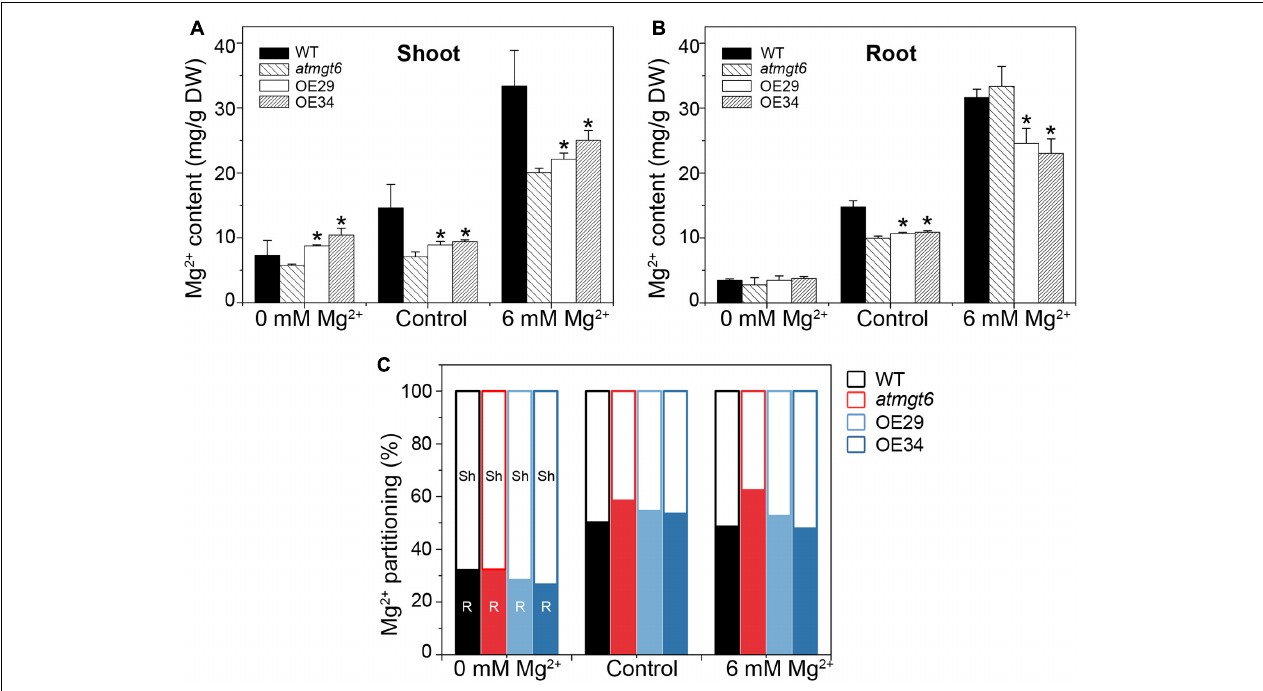
FIGURE 5 | Mg 2 + content and its partitioning in shoots and roots of atmgt6 and transgenic OsHKT2;4 -overexpression atmgt6 lines. Inductively Coupled Plasma-Mass Spectrometry (ICP-MS) analysis of Mg 2 + contents in shoots (A) and roots (B) of Col-0, atmgt6 and two transgenic OsHKT2;4 -overexpression atmgt6 lines, OE29 and OE34. After planted in the hydroponic medium containing 0.25 mM Mg 2 + for 2 weeks, Col-0, atmgt6 , OE29, and OE34 were transferred to the hydroponic medium containing 0, 0.25 (Control), or 6 mM Mg 2 + , and were harvested for elemental analysis of roots and shoots after growing for 2 days. Data are represented as the mean ± SD, n = 3. Asterisks indicate statistically significant differences compared with atmgt6 (Student’s t -test, ∗ P < 0.05). (C) Altered Mg 2 + partitioning between shoot (Sh) and root (R) in Col-0, atmgt6 , OE29, and OE34. Values are deduced from (A,B)